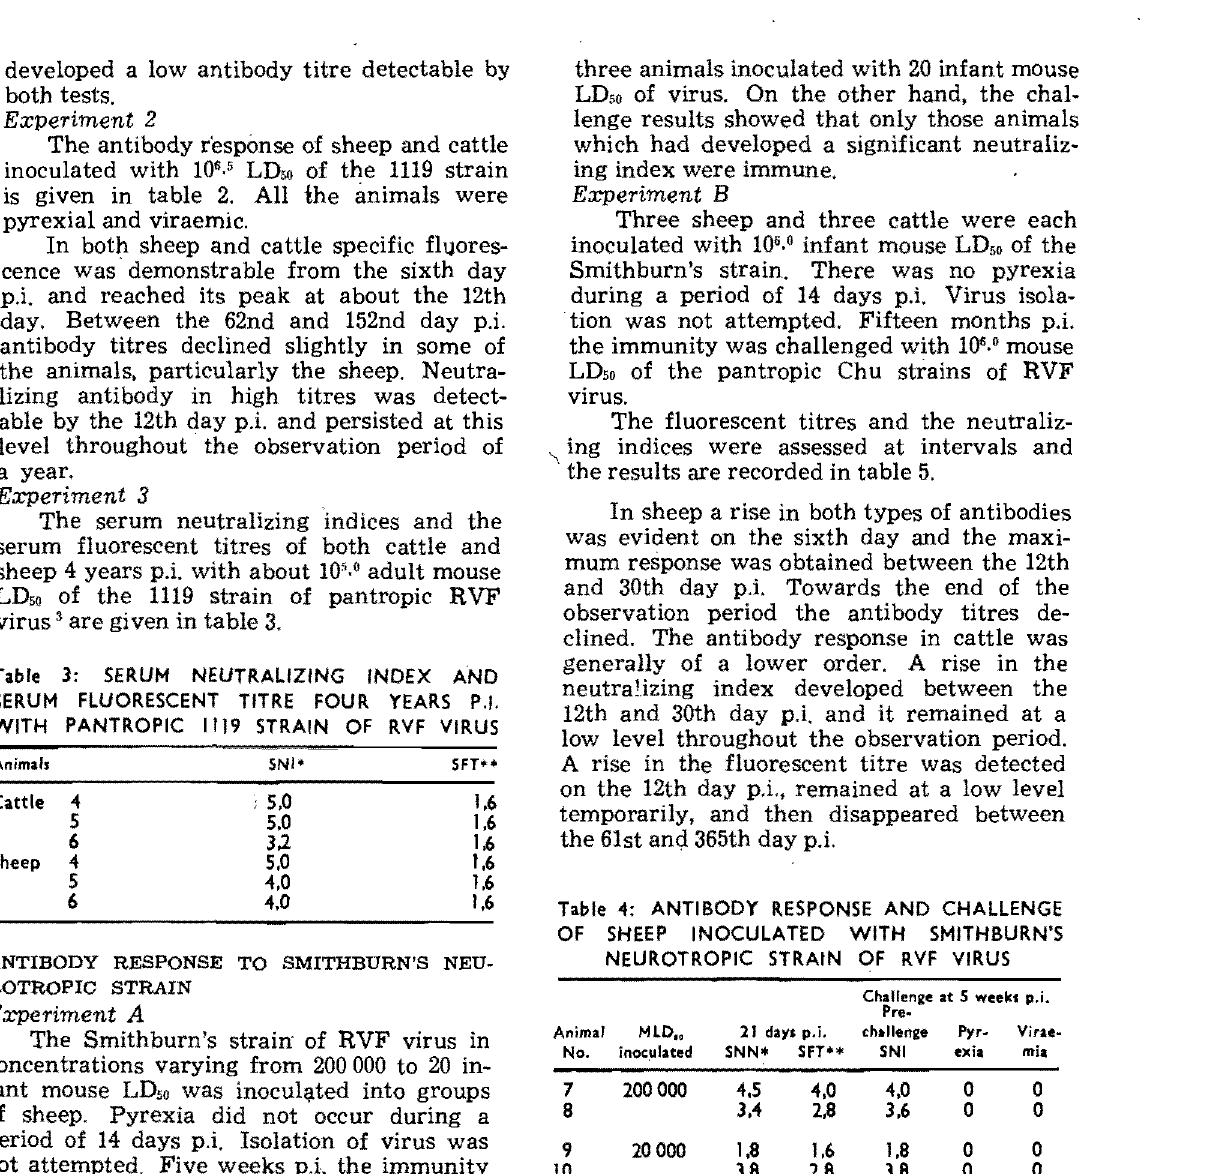
Table 3: SERUM NEUTRALIZING INDEX AND SERUM FLUORESCENT TITRE FOUR YEARS P.I.